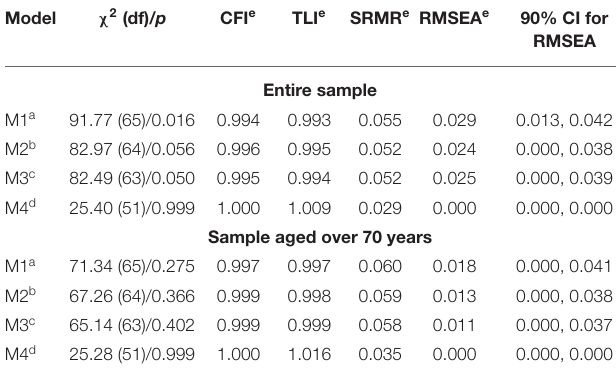
TABLE 1 | Participants’ characteristics. TABLE 2 | Model